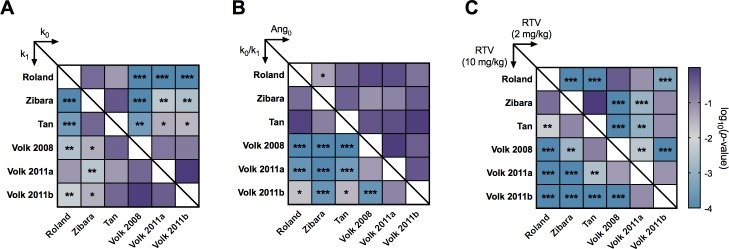
Statistical analysis of the optimized parameter sets.Standard ANOVA analysis followed by pairwise comparisons was used to determine whether the sets of optimized parameter values were statistically different. A, upper triangle: k0; lower triangle: k1. B, upper triangle: Ang0; lower triangle: k0/k1. C, upper triangle: RTV for bevacizumab dose of 2 mg/kg; lower triangle: RTV for dose of 10 mg/kg. The color and asterisks indicate log10(p-value): ***, (p-value ≤ 0.001); **, (0.001 < p-value ≤ 0.01); *, (0.01 < p-value < 0.05).